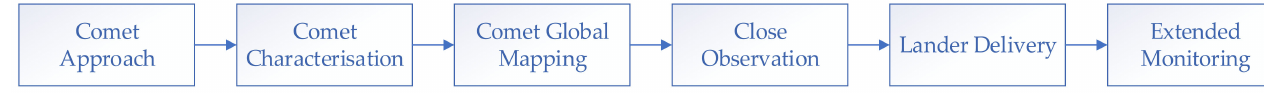
Figure A1. Rosetta mission operational phase.